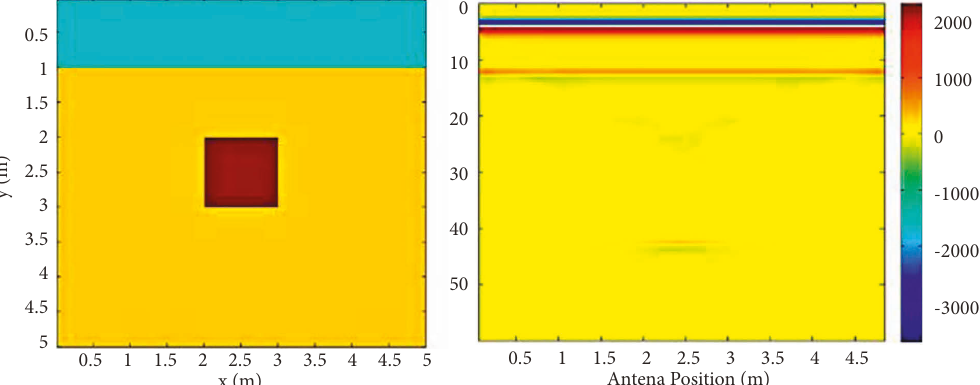
Figure 2: Layered oil and gas pollution model and forward modeling results, left x(m), right antenna position